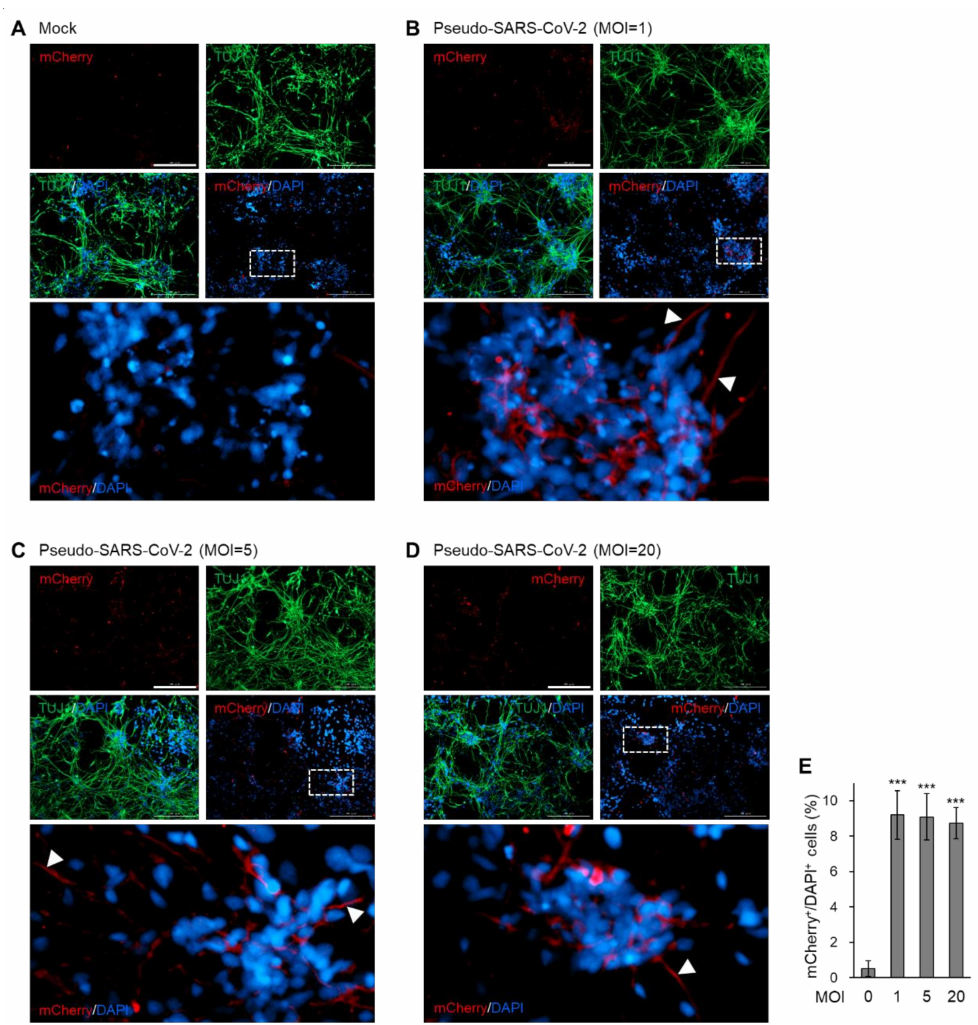
Figure 4. Neural infectivity of pseudotyped SARS-CoV-2 with di ff erent doses. ( A ) Immunofluorescence of mock-treated monolayer cortical neurons for detecting pseudotyped SARS-CoV-2 spike (mCherry) and TUJ1. ( B–D ) Immunofluorescence of monolayer cortical neurons, which were incubated with MOI = 1 ( B ), 5 ( C ), or 20 ( D ) of SARS-CoV-2 pseudovirus for detecting pseudotyped SARS-CoV-2 spike (mCherry) and TUJ1. White arrow, mCherry signal detected in axons. Scale bar, 200 µ m. ( E ) Quantification of immunofluorescence indicates the percentage of mCherry-positive cells among the total DAPI-positive cells. In E, data are presented as mean ± SD ( n = 4). * p < 0.05; ** p < 0.01; *** p <